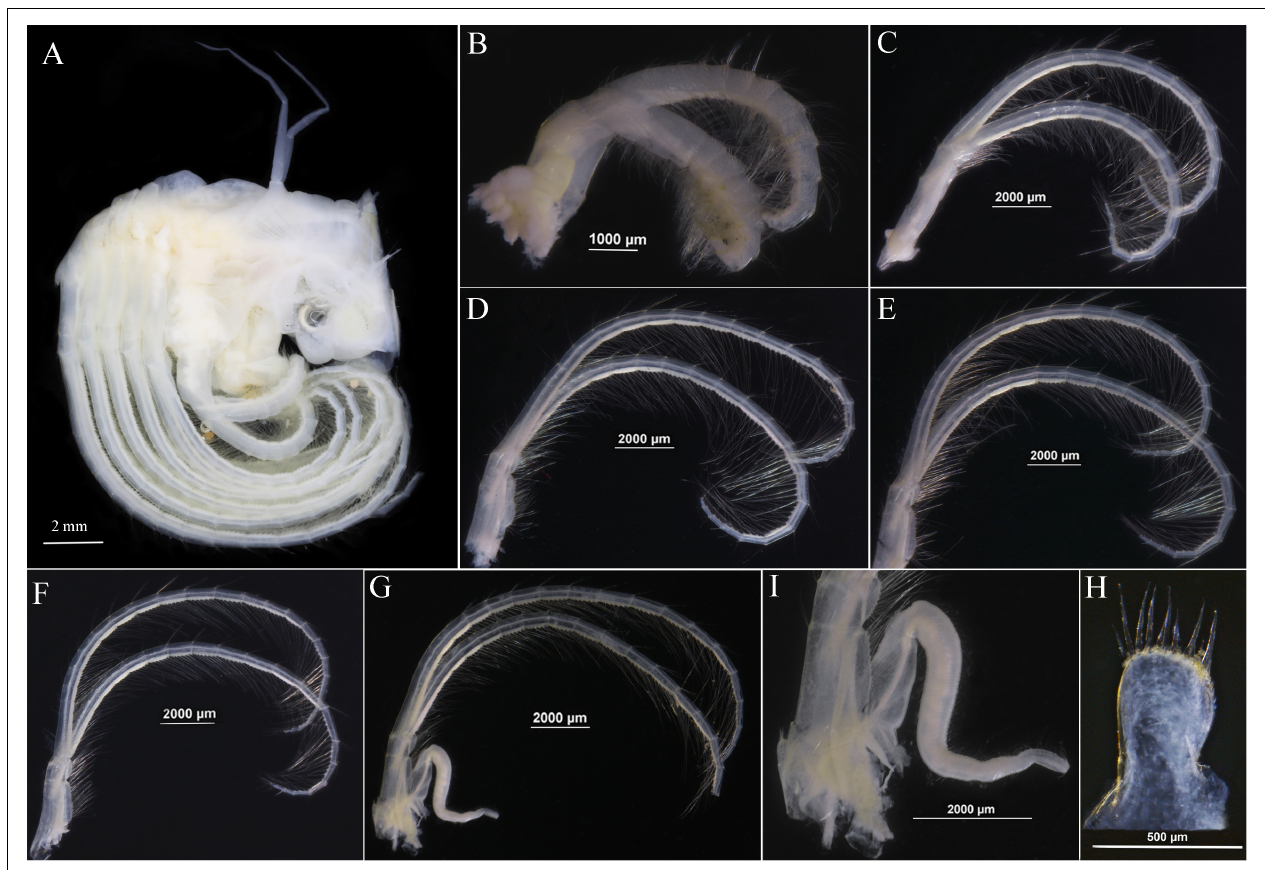
FIGURE 7 | Glyptelasma robustum sp. nov. holotype. (A) Soft body. (B) Cirrus I. (C) Cirrus II. (D) Cirrus III. (E) Cirrus IV. (F) Cirrus V. (G) Cirrus VI. (H) Caudal appendage. (I)